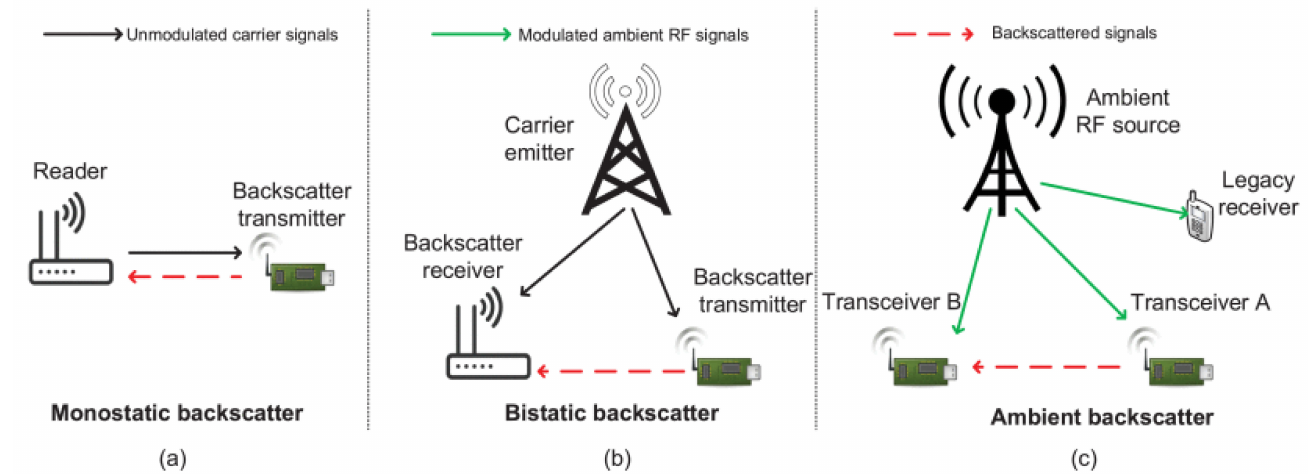
Figure 9. Paradigms for backscatter communications [134]. ( a ) Monostatic backscatter; ( b ) Bistatic backscatter; ( c ) Ambient